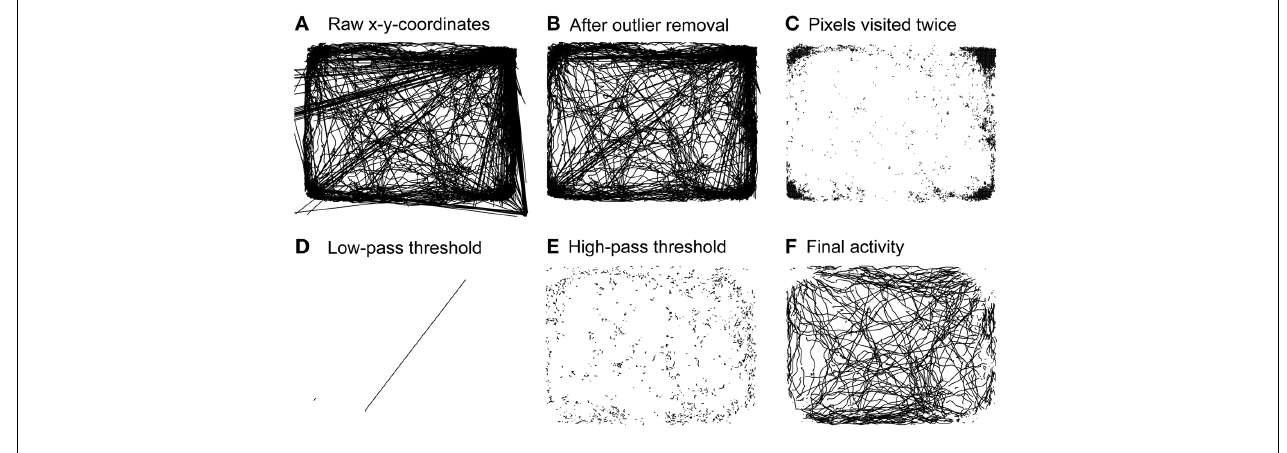
FIGURE 2 | Steps of behavioral analysis. Activity of a representative rat during 23hours of pre-operative monitoring. (A) Raw activity including all artifacts. (B) Activity remaining after outlier rejection. (C) Spaces on the single pixel level that were “visited” twice during the